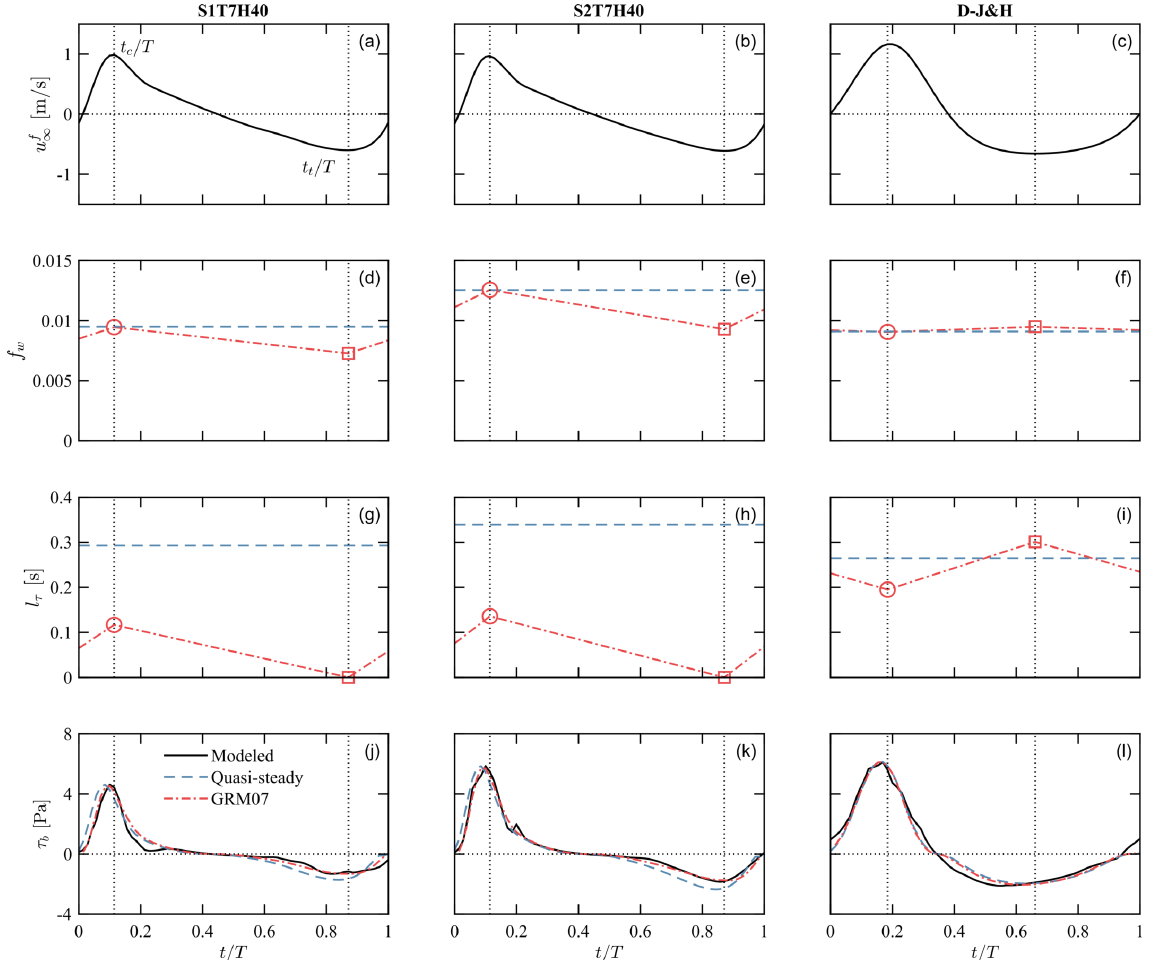
Figure 11. Time series of ( a – c ) free stream velocity, ( d – f ) wave friction factor, ( g – i ) time-lag, and ( j – l ) bed shear stress (black solid curves, directly modeled; blue dashed curves, quasi-steady approach; red dash–dot curves, GRM07) for the present ( a , d , g , j ) S1T7H40 and ( b , e , h , k ) S2T7H40 cases, and a ( c , f , i , l ) previously reported D-J&H case [43]. Vertical dotted lines represent t = t c (circles, f w , G ( t c / T ) and l τ , G ( t c / T ) ) and t = t t (squares, f w , G ( t t / T ) and l τ , G ( t t / T )